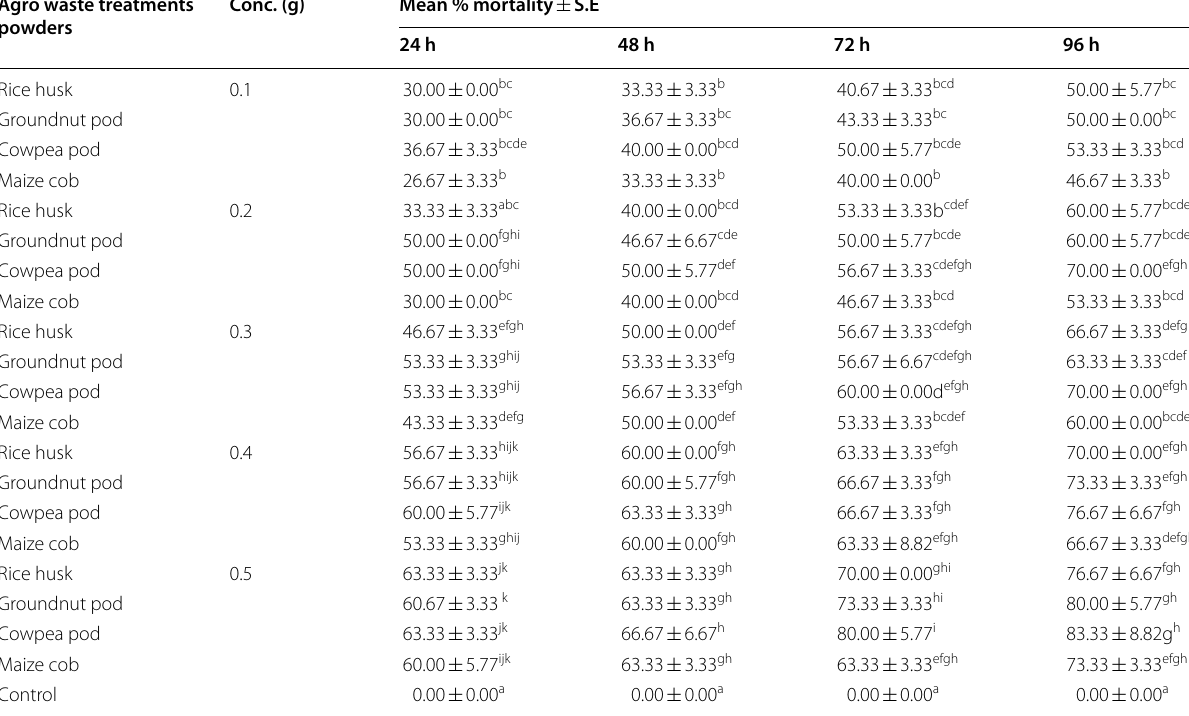
Mean followed by the same letters within the same column are not significantly different ( p > 0.05)